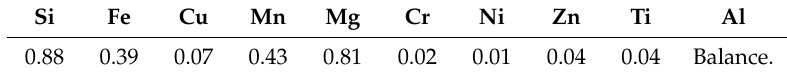
Table 1. Chemical composition of the commercial AA6082, in weight